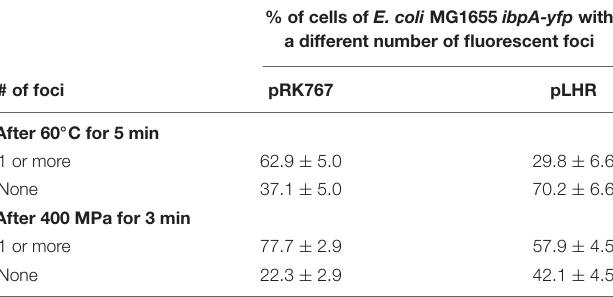
TABLE 4 | Differential enumeration of cells containing none, or one or more foci representing protein aggregates in E. coli MG1655 ibpA-yfp (pRK767) and E. coli MG1655 ibpA-yfp